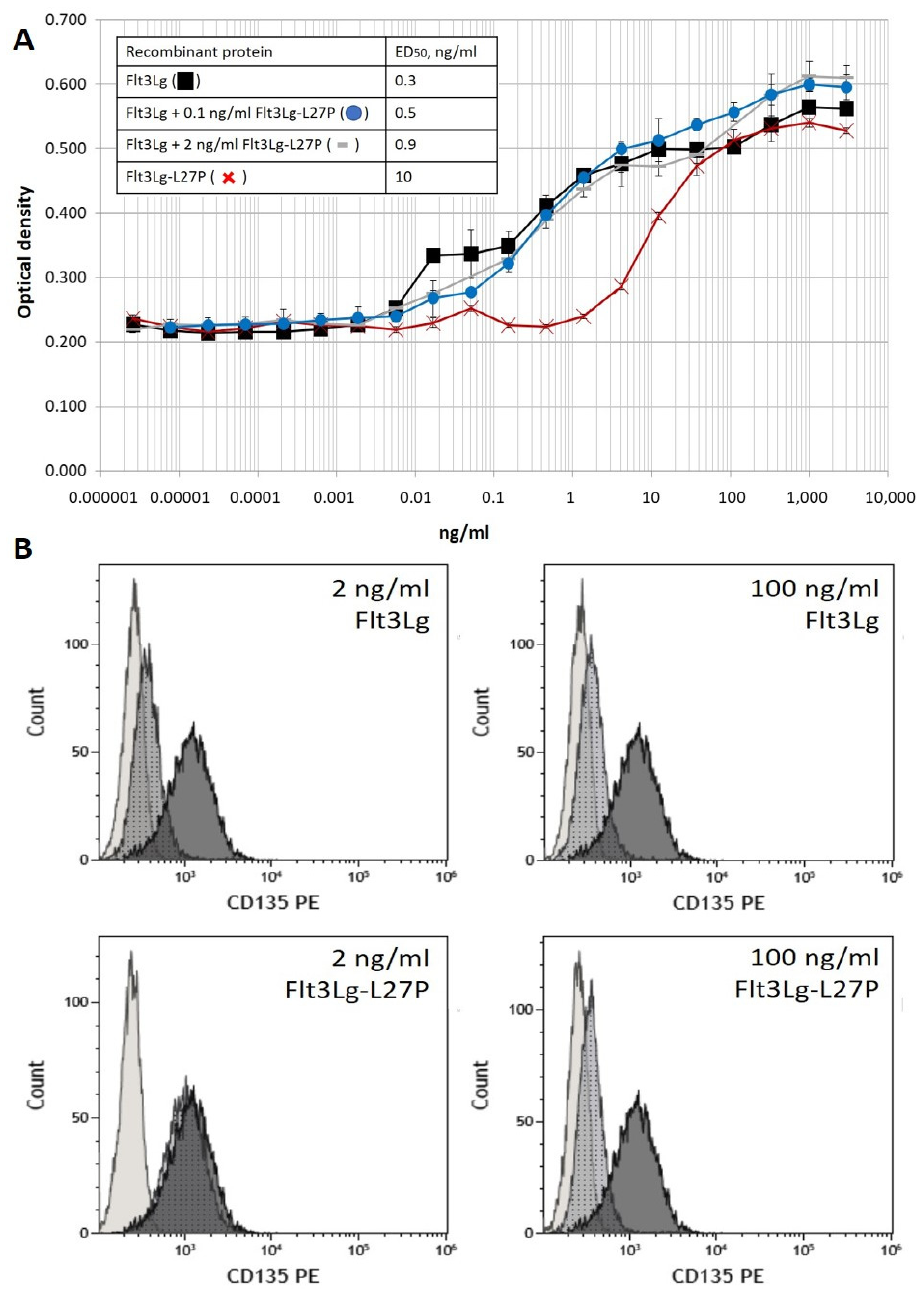
Figure 1. ( A ) Measuring ED 50 for recombinant Flt3Lg-L27P and Flt3Lg via induced proliferation in the THP-1 cell line. Stimulated proliferation was assessed in the MTS assay. ED 50 concentrations were determined using the mean OD values of the lower and upper plateaus. Black squares correspond to wild-type Flt3Lg and red crosses to Flt3Lg-L27P. Wild-type Flt3Lg-stimulated THP-1 proliferation in the presence of 0.1 ng/mL (blue circles) or 2 ng/mL (gray dashes) was also assessed. Data were represented as mean ± SD. ED 50 values are presented in the figure. ( B ) Stimulation of Flt3 downregulation in the THP-1 cell line using recombinant Flt3Lg and Flt3Lg-L27P. THP-1 cells were incubated in the presence of 2 or 100 ng/mL of either Flt3Lg (upper pictures) or Flt3Lg-L27P (lower pictures) for 18 h. The expression of Flt3 in THP-1 cells was detected using flow cytometry after staining the cells with an anti-CD135-PE antibody. For all pictures, dark grey histograms correspond to non-stimulated THP-1 stained with anti-CD135-PE, light-grey histograms correspond to non- stained THP-1 cells, and dotted histograms correspond to stimulated THP-1 cells stained with